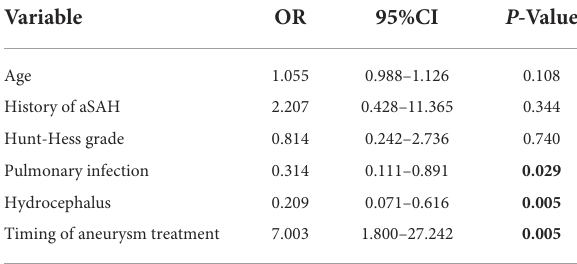
TABLE 4 Multivariable model for good prognosis (mRS 0-2) in patients with high-grade